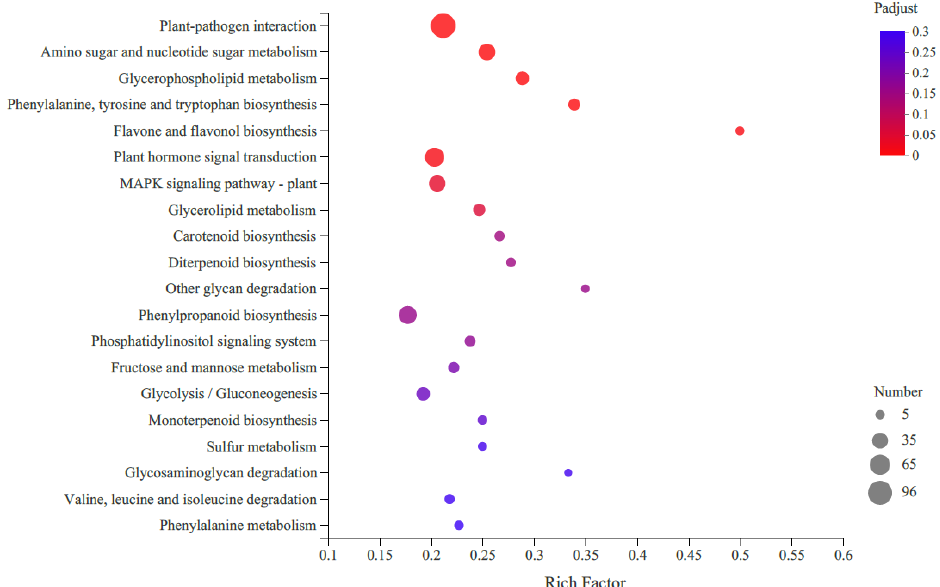
Figure 3. Top 20 enriched KEGG pathways of differentially expressed genes (DEGs) in R-HJH compared with HJH. The X-axis shows the rich factor. A high q-value is represented by blue, and a low q-value is represented by red ( p value < 0.05). The Y-axis represents the second KEGG pathway terms. The number of DEGs is represented by the size of the circle.